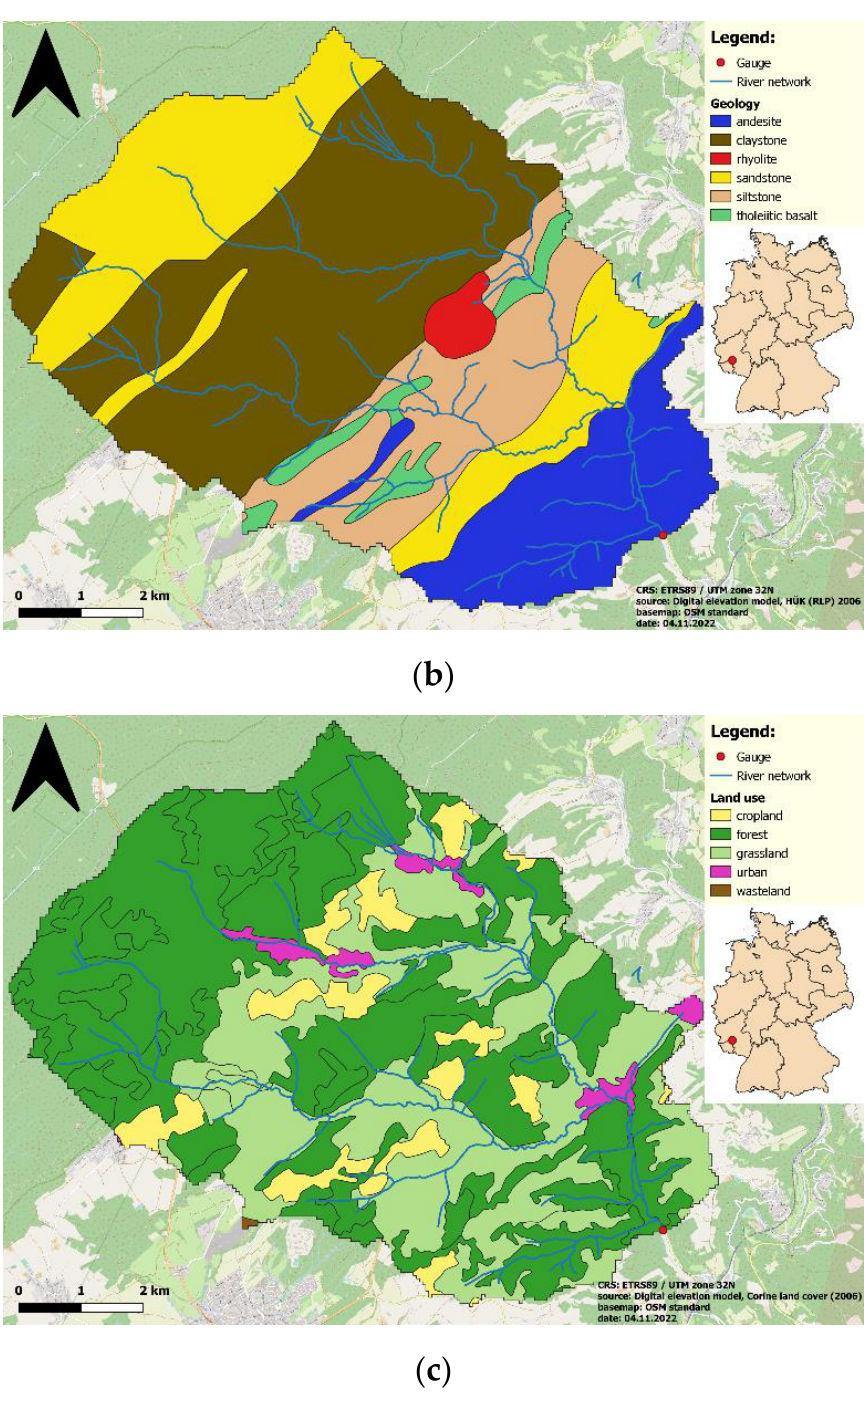
Figure 1. Topography ( a ), geology ( b ), and land use ( c ) of the Kronweiler catchment.